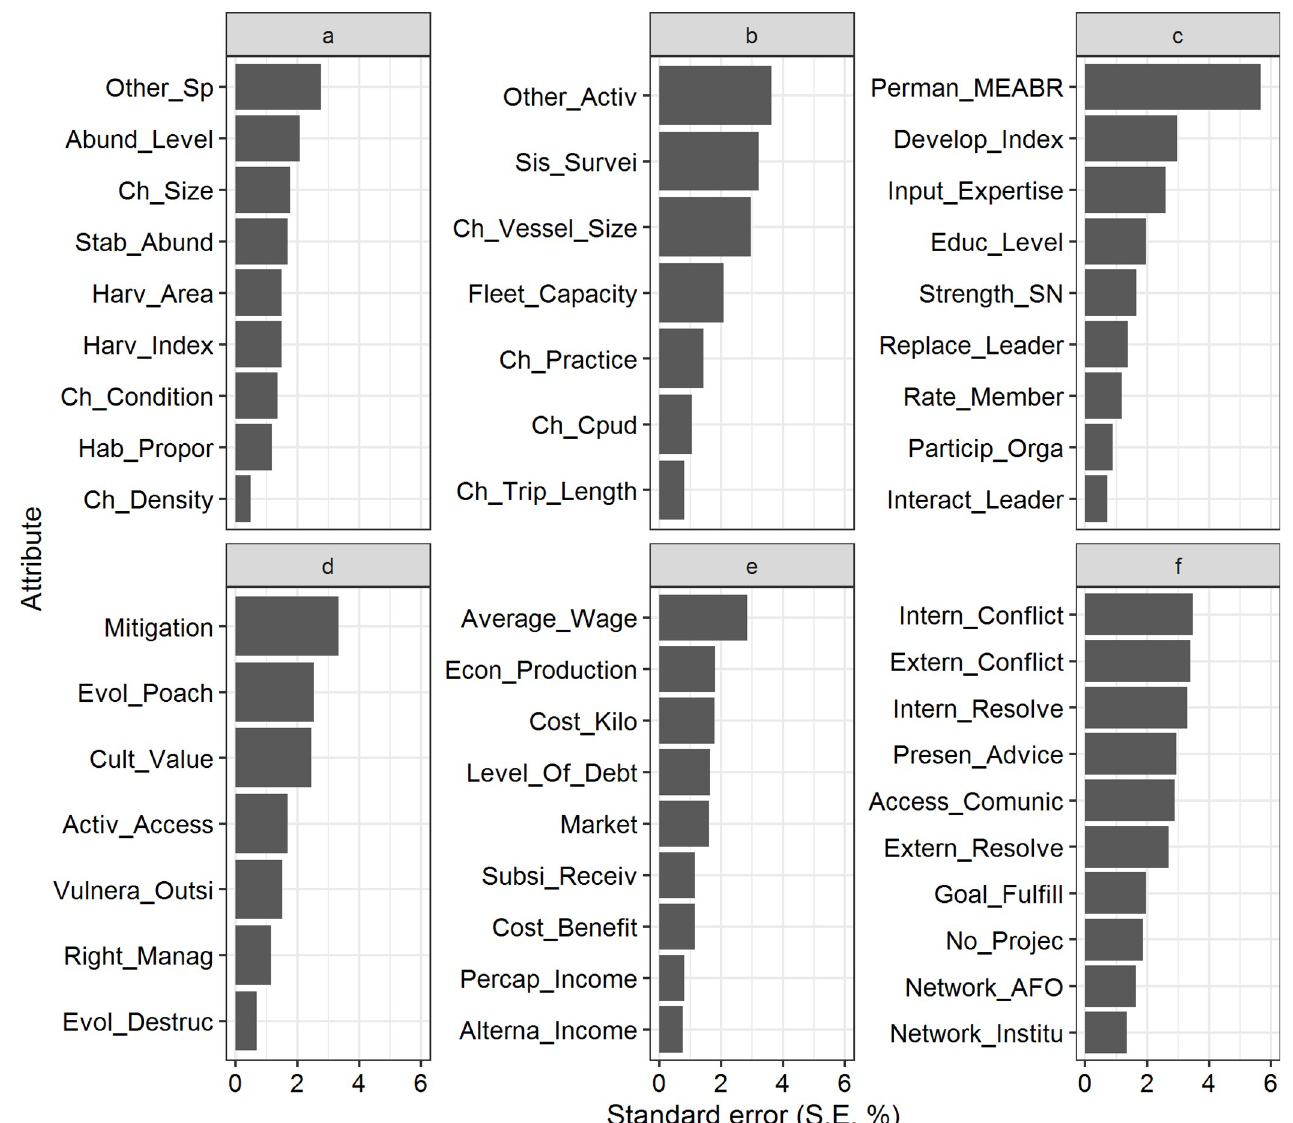
Fig 3. Leverage of attributes, given by standard error (S.E. %), in each Rapfish dimensions for MEABR system. (a) ecological, (b) technological, (c) social, (d) ethical, (e) economic and (f) institutional dimensions. Root mean square % change in ordination position when selected attribute removed (on status scale 0 to